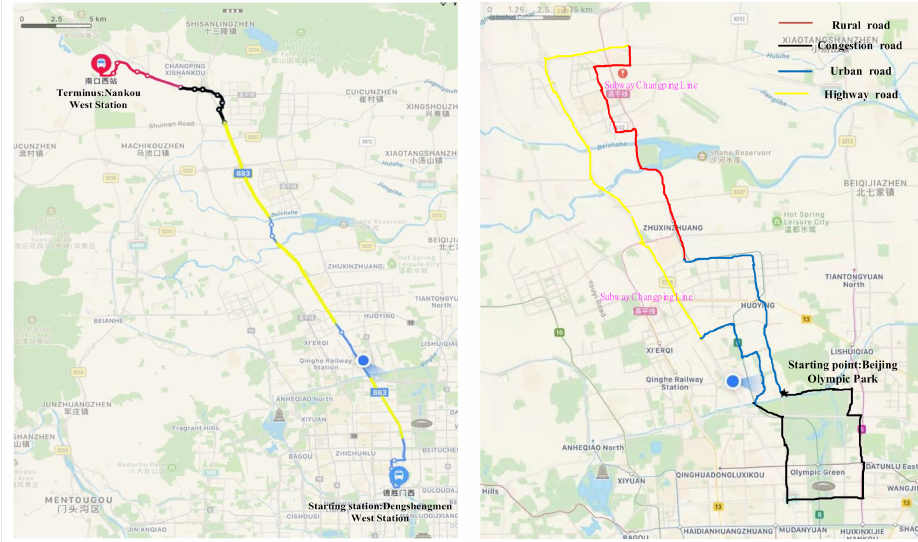
Figure 1. Routes of Bus 883 and a private car in